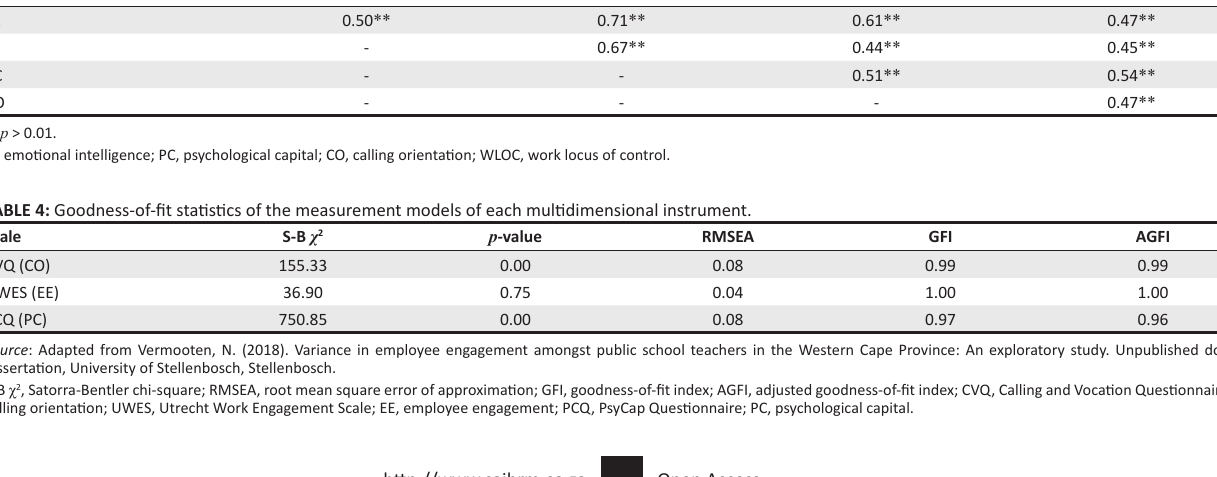
TABLE 3: Intercorrelational matrix of the latent variables ( N = 353). Variables EI PC